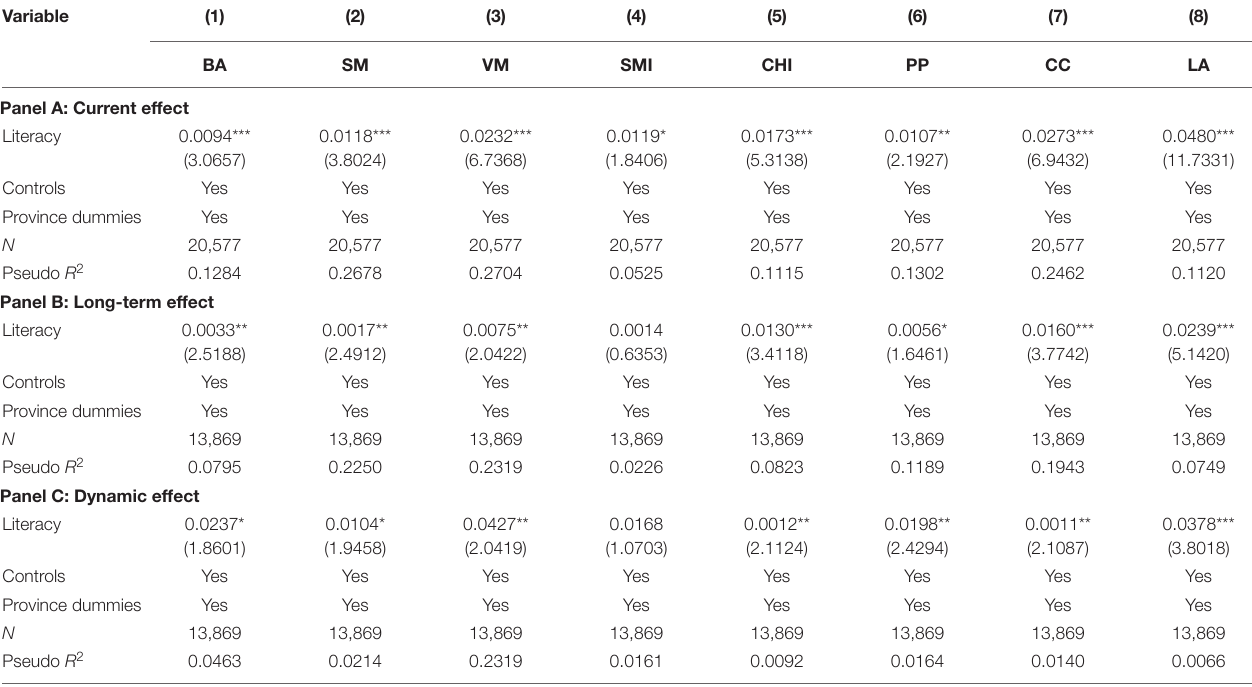
TABLE 9 | Robust test by considering proxy indicators of financial